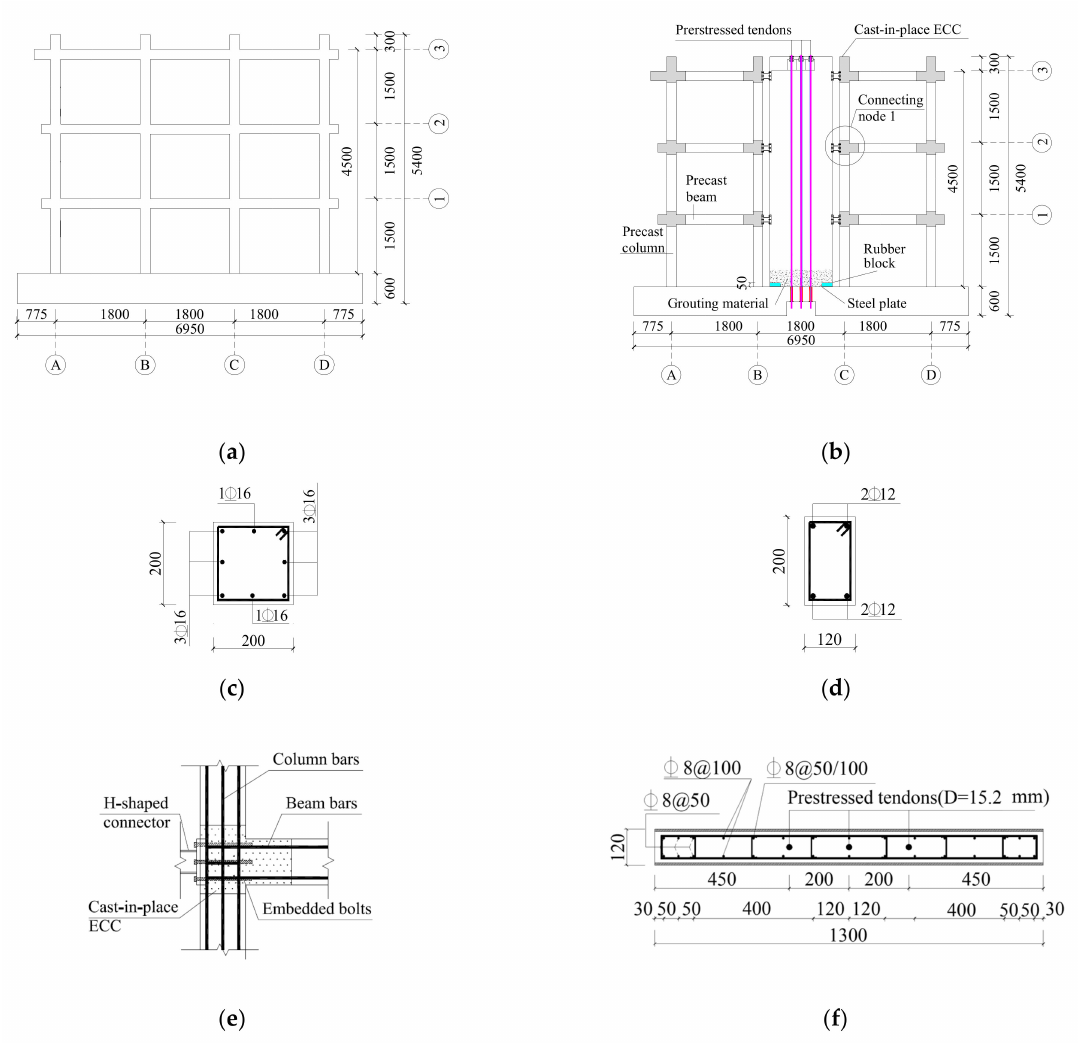
Figure 1. Test specimen dimensions and reinforcement (unit: mm). ( a ) Geometry of CF; ( b ) Geometry of PFRW; ( c ) frame column; ( d ) frame beam; ( e ) typical cast-in-place beam-column connection (connecting node 1); ( f ) rocking